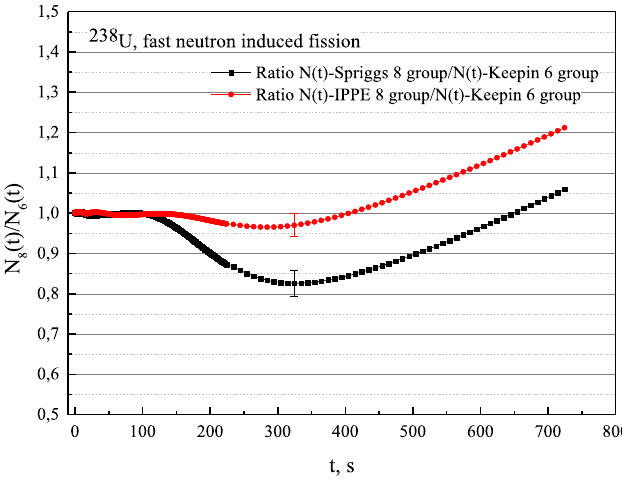
Fig. 2. The ratio of the decay curves calculated on the basis of the 8-group DN dataset with the LANL and the IPPE expansion methods to the DN decay curve obtained with the original 6-group data for 238 U by Keepin